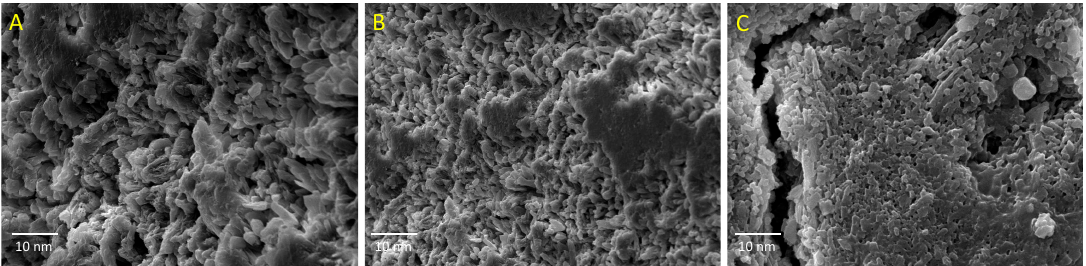
Figure 5. SEM micrographics of PSAH ( A ), PGAH ( B ), and PAAH ( C ).